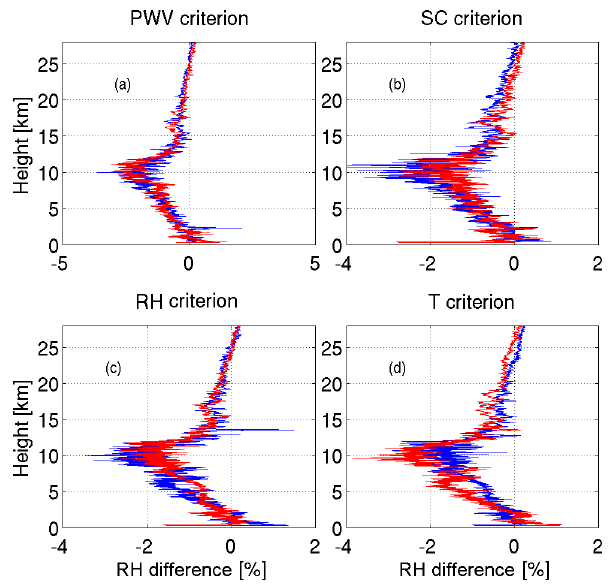
Figure 16. Same as Fig. 14 but for relative humidity differences.